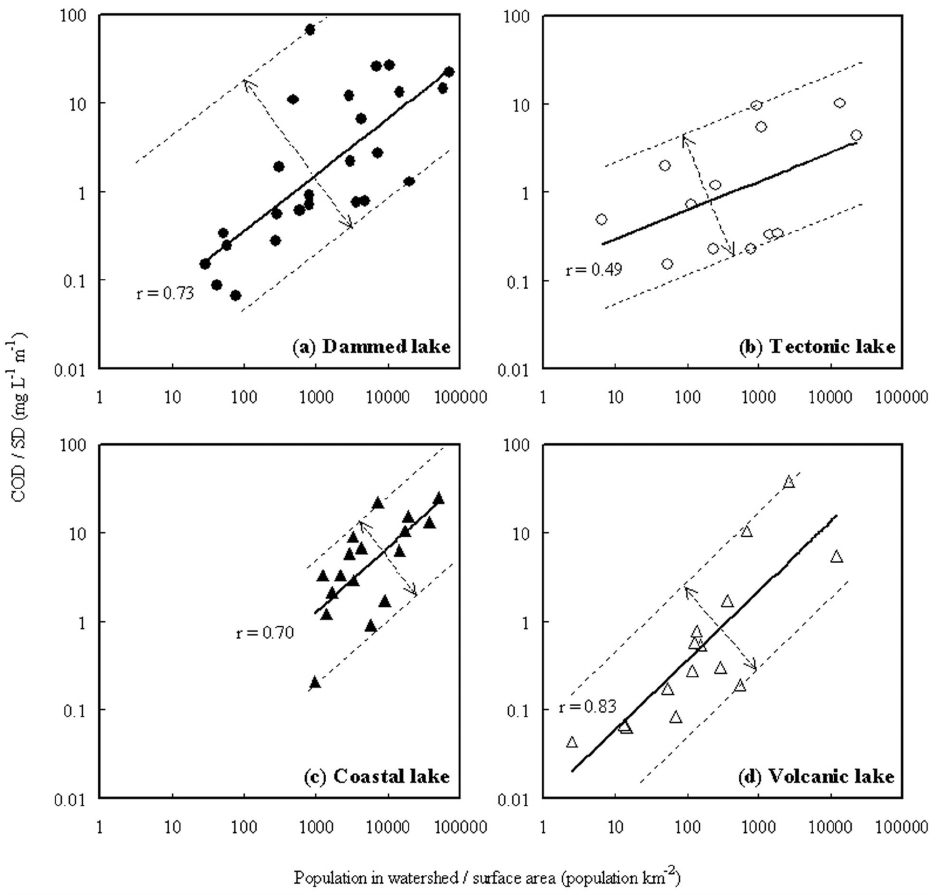
FIGURE 7. Difference in trophic state represented from the viewpoint of lake origin. Data plots were cited from the articles reported by Taki and Tanaka[22,37] with some arrangements. Sample size: n = 26 for dammed lake, n = 13 for tectonic lake, n = 17 for coastal lake, n = 15 for volcanic